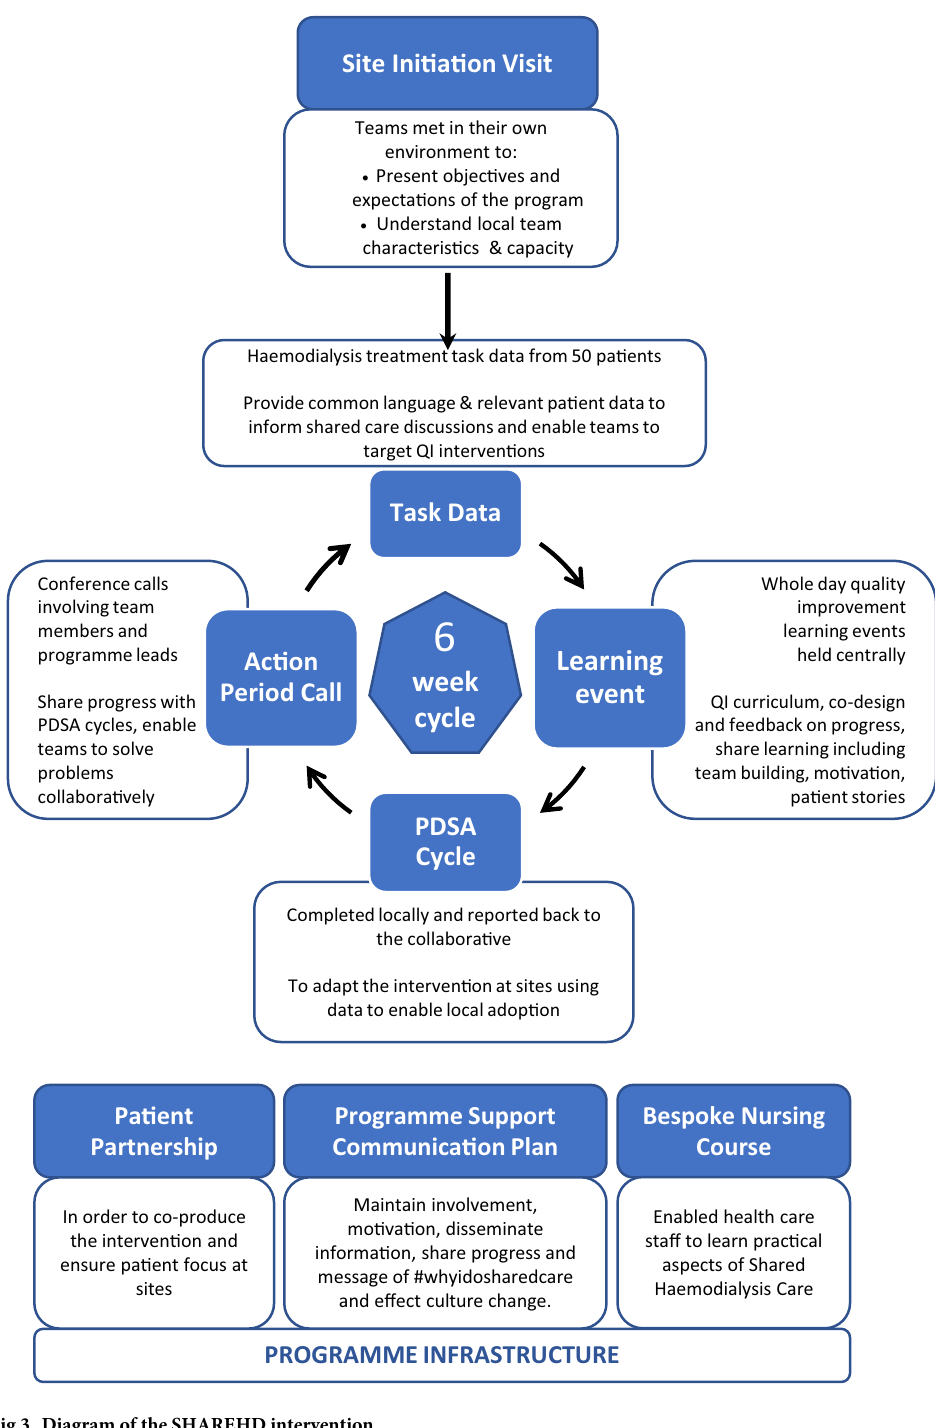
Fig 3. Diagram of the SHAREHD